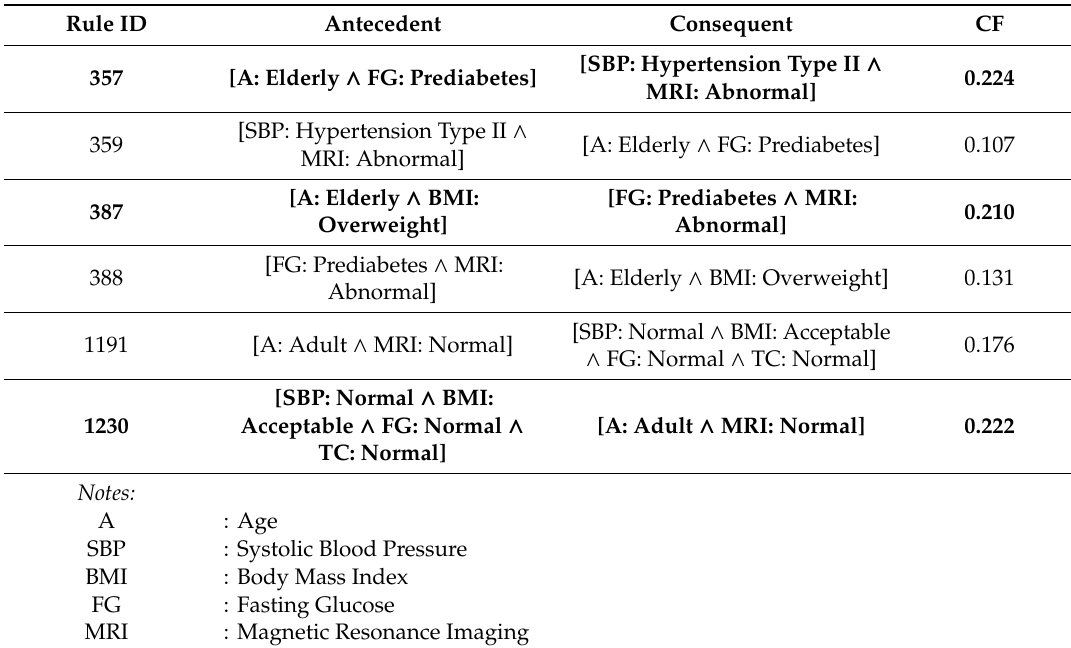
Table 8. Example result of direct-circular type I.